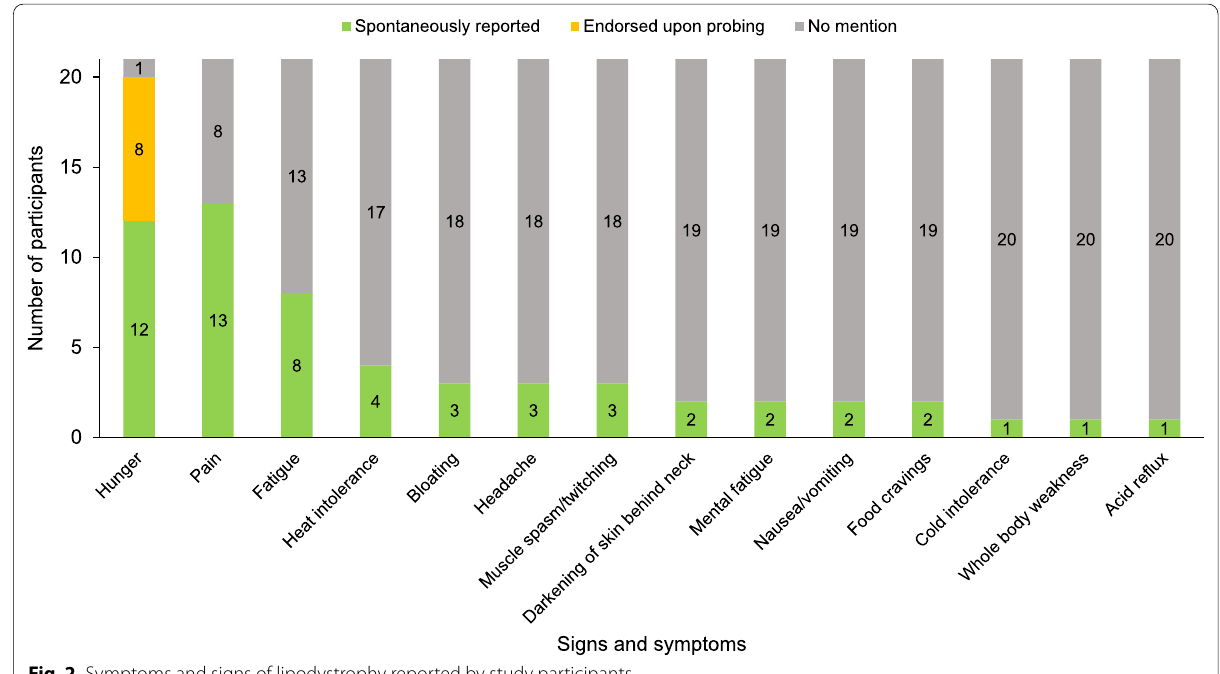
Fig. 2 Symptoms and signs of lipodystrophy reported by study